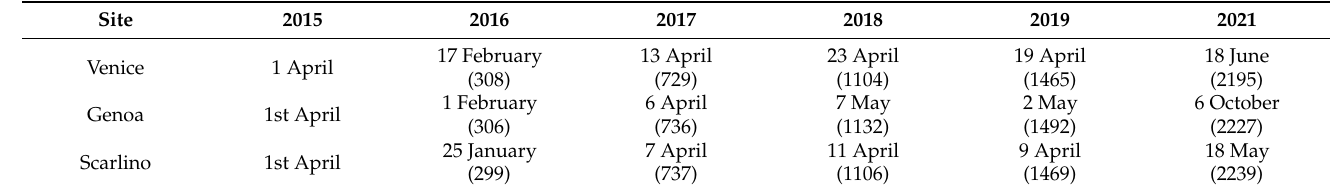
Table 2. Evaluation dates of racks. In brackets are the cumulative days of immersion.